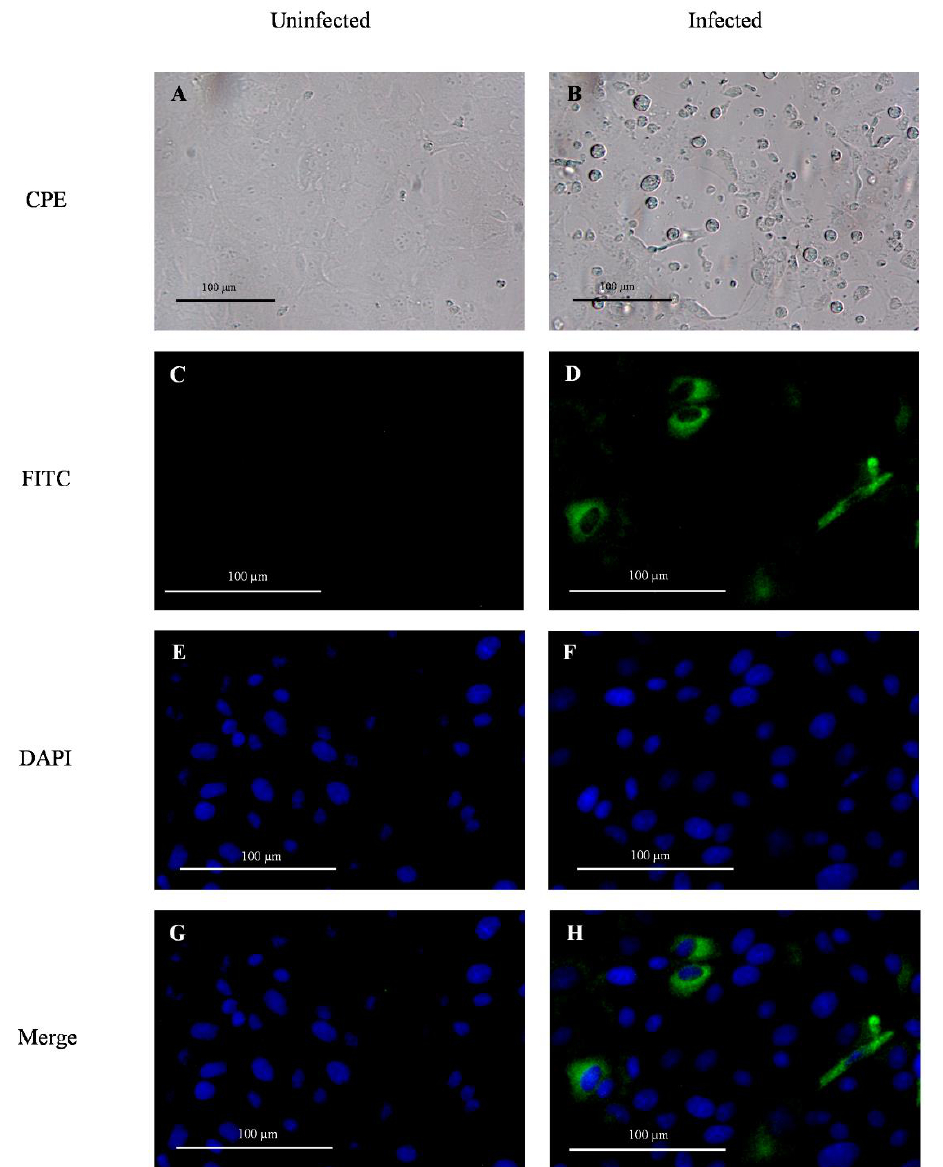
Figure 1. Detection of porcine deltacoronavirus (PDCoV) infection and replication in monolayer cultures of swine testicular (ST) cells in vitro via observation of cytopathic effect under the inverted microscope (CPE), and the expression of viral protein N (green fluorescence) revealed by immunofluorescent antibody assay (IFA). The negative infection control was inoculated with culture medium ( A , C , E , G ), while the positive infection control corresponded to ST cells inoculated with PDCoV (1.1 × 10 5 TCID 50 /mL) ( B , D , F , H ). PDCoV IFA was performed using mouse IgG1 fluorescein isothiocyanate (FITC; green)-conjugated anti-PDCoV N protein monoclonal antibody (Medgene) diluted 1:150 in phosphate-buffered saline with 0.1% bovine serum albumin and nuclear counterstain with DAPI (blue). Images were obtained using a fluorescence inverted microscope (Olympus Life Science, FCKX41) with the camera INFINITY 2 (Lumenera) at 20X magnification.